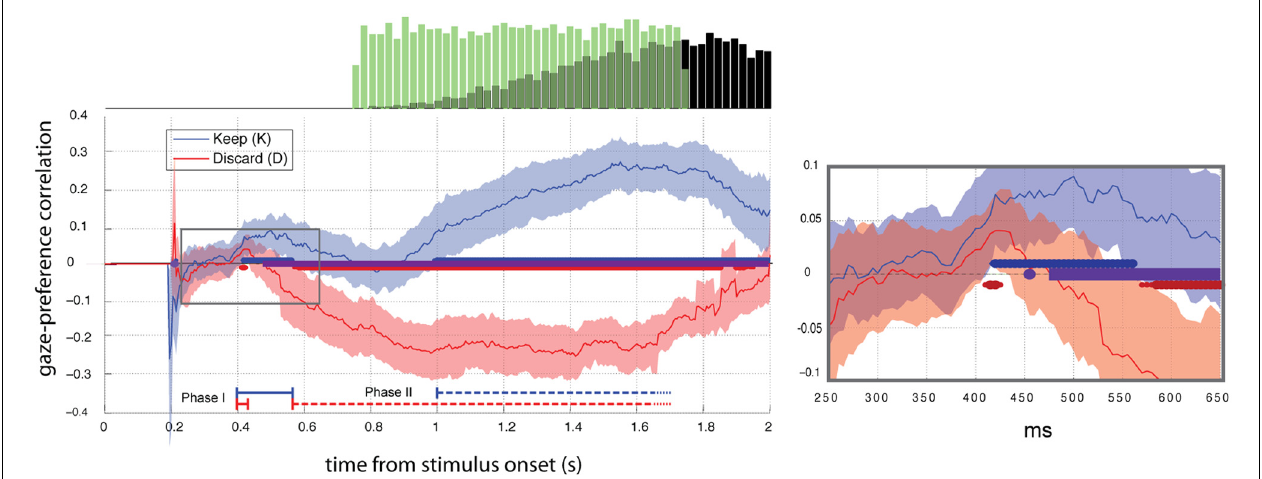
FIGURE 2 | Gaze preference effect aligned to stimulus onset ( t = 0). Mean ± 2 SEM gaze-preference correlation curve for each condition ( N = 23). Thick blue and red lines at the x -axis indicate significant deviations from zero (FDR corrected Q < 0.05). Periods of significant